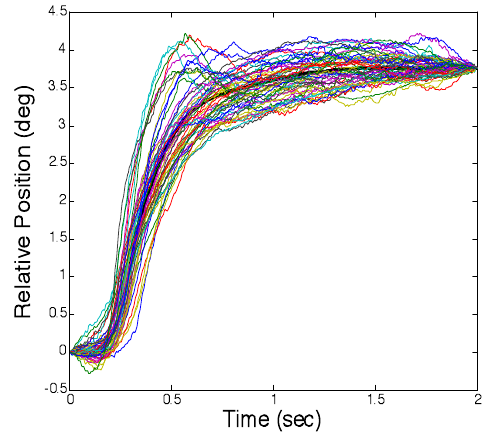
Figure 1 An ensemble of 42 responses to a 4 deg. pure vergence step change plotted as vergence. Convergence is plotted upward. These convergence responses were selected from a much larger run that included divergent